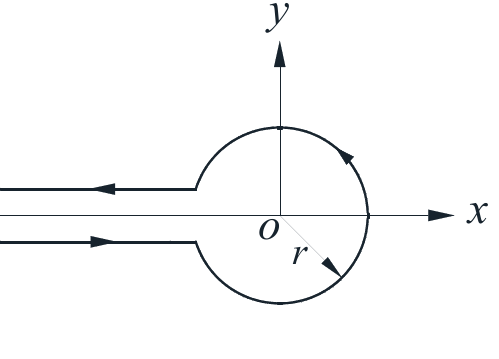
Figure 4. Path of Hankel integral.